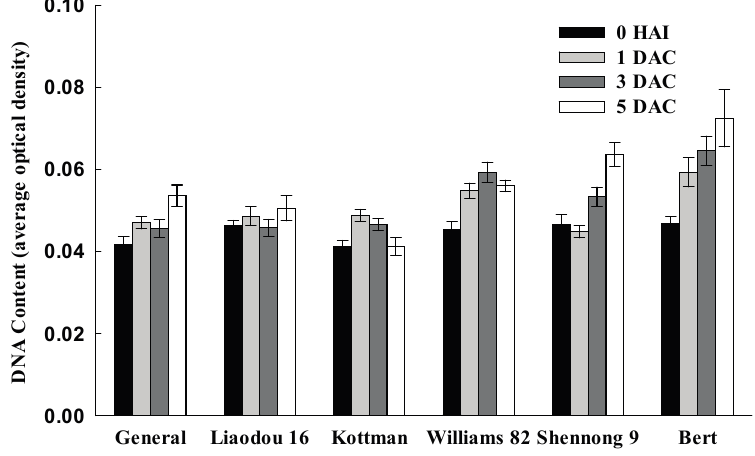
Figure 6. Comparison of nuclear DNA content in meristem cells of cotyledonary nodes between different genotypes during the co-cultivation period. The data represent the means ± SD of all cell nucleus in the cotyledonary